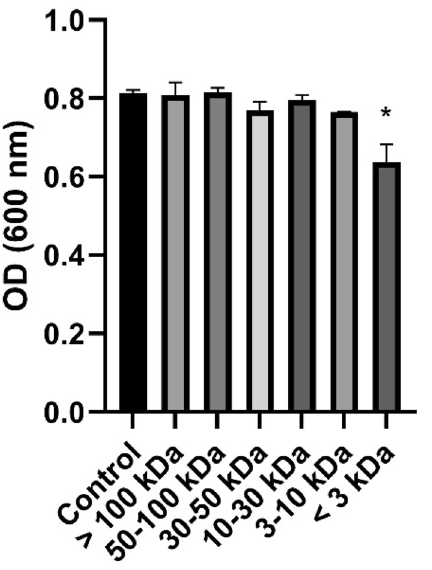
Figure 2. Optical density (OD) of Gardnerella vaginalis suspension incubated for 24 h with 5% (v/v) Lactobacillus paracasei CH88 cell-free supernatant fractions with different molecular weights. Bars are means and standard errors of the means (n = 3) of triplicate experiments. *Significant difference compared to the control ( p < 0.05; one-way ANOVA with Dunnett’s multiple comparison test).